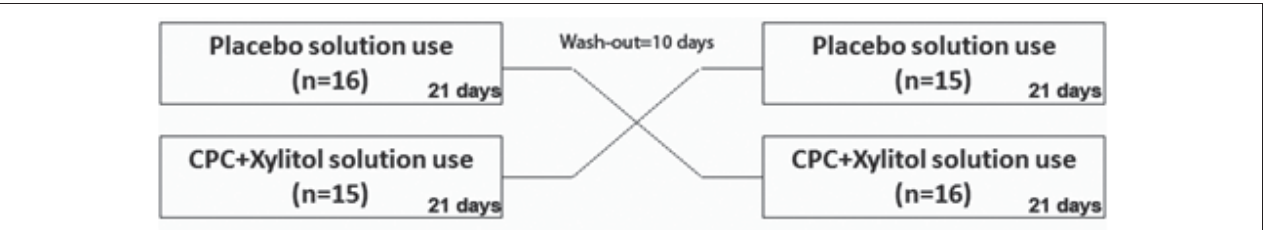
Fig. 1. Study design and flowchart of the present crossover